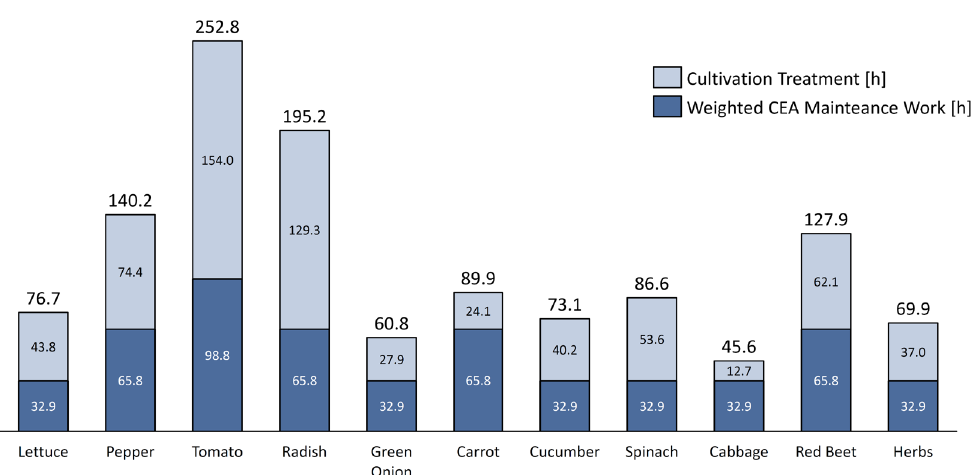
Figure 17: Total work duration [h] per crop type with weighted CEA times. The figure depicts cultivation treatment duration per crop type (light blue bars) and weighted CEA work durations (dark blue bars).